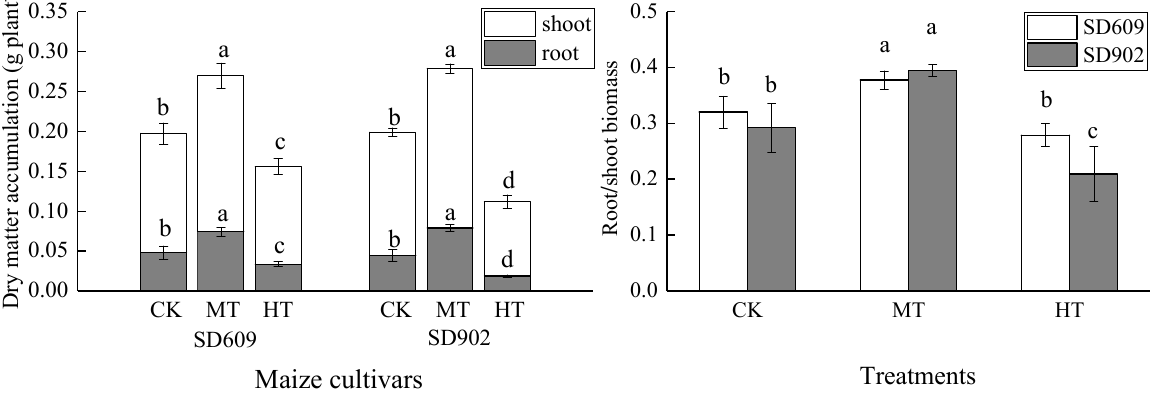
Figure 1. Effects of different root zone temperatures on dry matter accumulation and root/shoot biomass of SD609 and SD902. root zone normal-temperature treatment (CK): 24 ◦ C, root zone medium-temperature treatment (MT): 30 ◦ C, root zone high-temperature treatment (HT): 36 ◦ C (root zone temperature). Notations above bars of a, b, c, and d indicate homogeneous groups ( α =